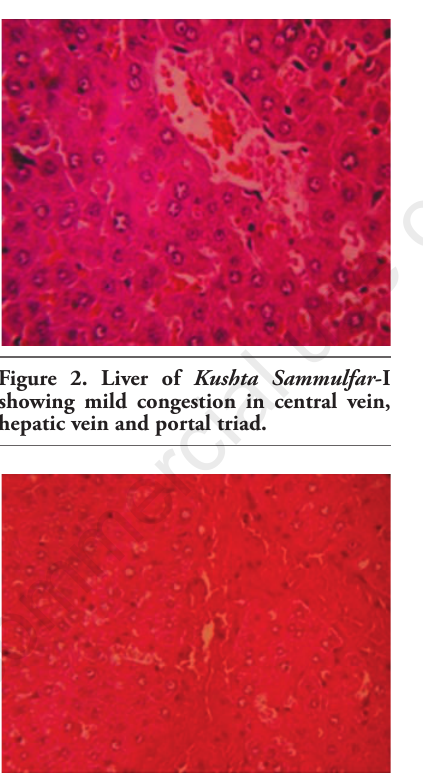
Figure 7. Kidney of Kushta Sammulfar -II showing tubular damage, vascular conges- tion, mild interstitial edema and occasion- al inflammatory cells.